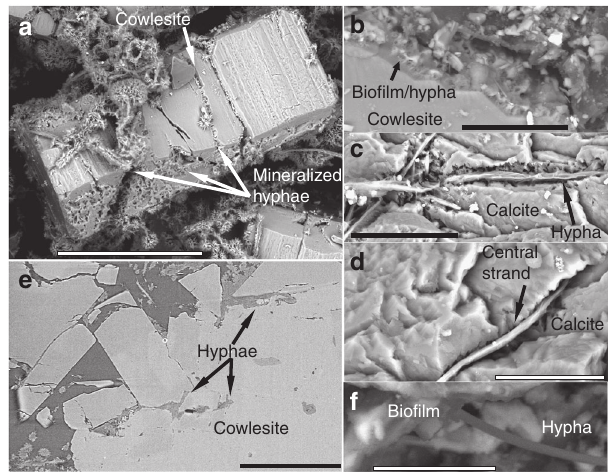
Fig. 2 Cryptoendolithic features of hyphae and weathering of zeolite and calcite. Back-scattered Environmental Scanning Electron Microscopy (ESEM)-images ( a – d , f ) and Synchrotron Radiation X-ray Tomographic Microscopy (SRXTM)-section ( e ). ( a ) Heavily wheathered cowlesite (zeolite mineral) covered by hyphae (now mineralized). ( b ) Chemical weathering front in the contact between fungi and cowlesite. ( c , d ) Hyphae penetrating micro-fractures into calcite. Only the central strand of the hyphae is remaining in most parts. ( e ) SRXTM cross-section showing hyphae between cowlesite grains and within cracks in the minerals. ( f ) Bio fi lm on mineral surfaces with hypha extending out from the bio fi lm. Scale marker bars are 200 µ m ( a ), 30 µ m ( b ), 40 µ m ( c ), 20 µ m ( d ),